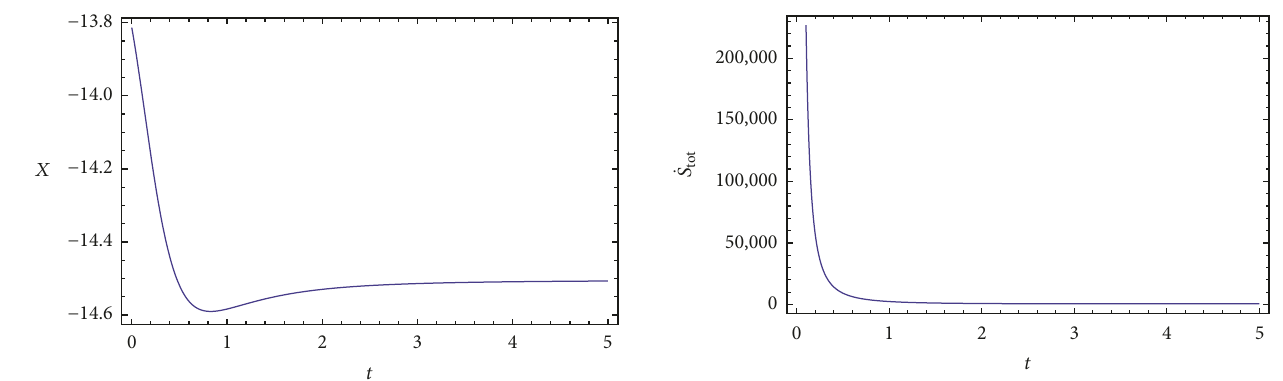
̇𝑆 Figure 7: Plot of tot by taking power law entropy as entropy at apparent horizon, where time is measured in